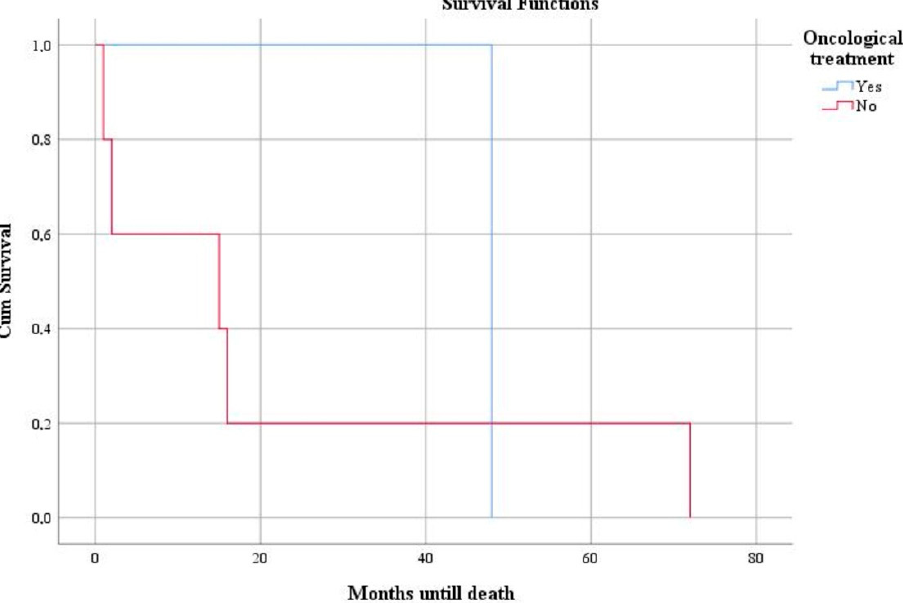
Figure 6. Kaplan–Meier survival graphic that shows a lower survival rate in cases without onco- logical